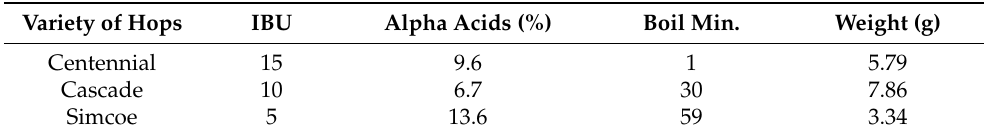
Table 2. Characteristics of the brewing pelleted hops used, the hops’ addition time during boiling, and the amount of hops used in each treatment (5 L). Variety of Hops IBU Alpha Acids (%) Boil Min. Weight (g) Centennial 15 9.6 1 5.79 Cascade 10 6.7